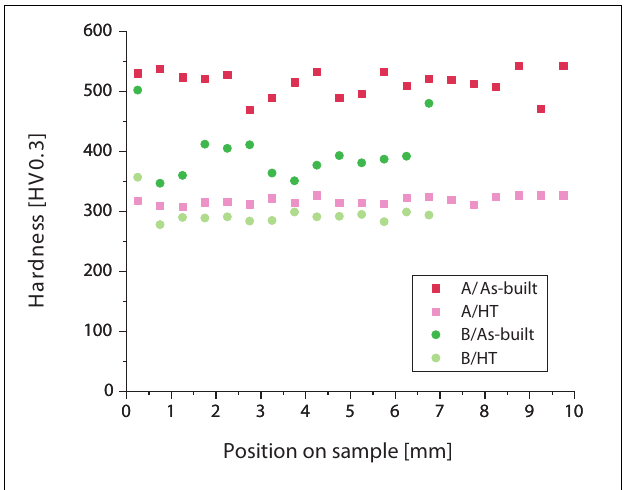
FIGURE 9 | Hardness values along sample centerline for A and B samples in as-built and heat treated condition.